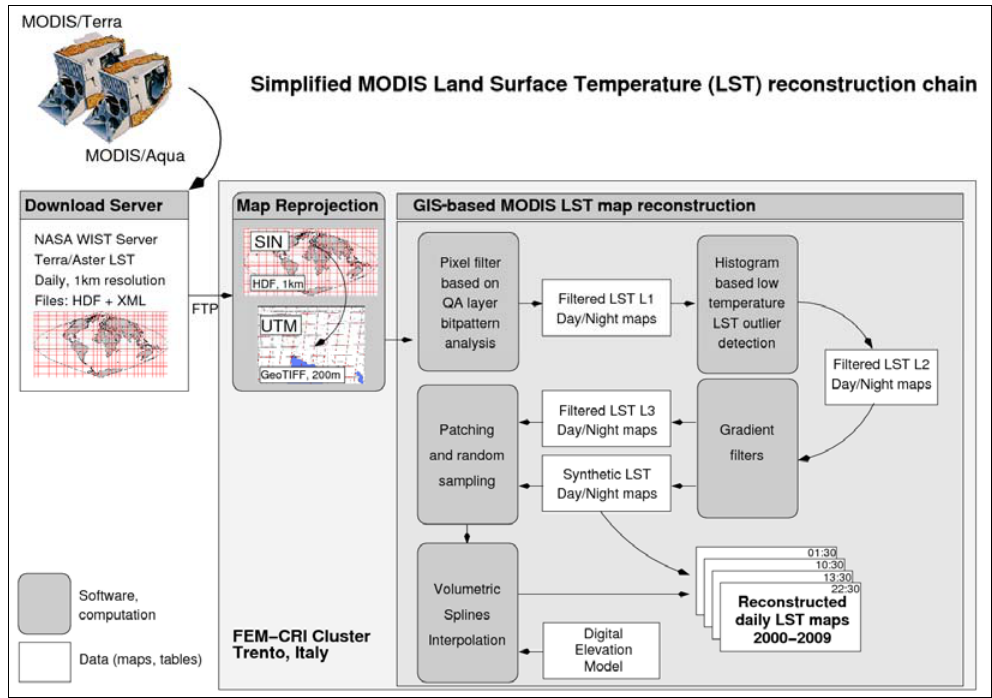
Figure 2. Simplified sketch of MODIS LST reconstruction processing